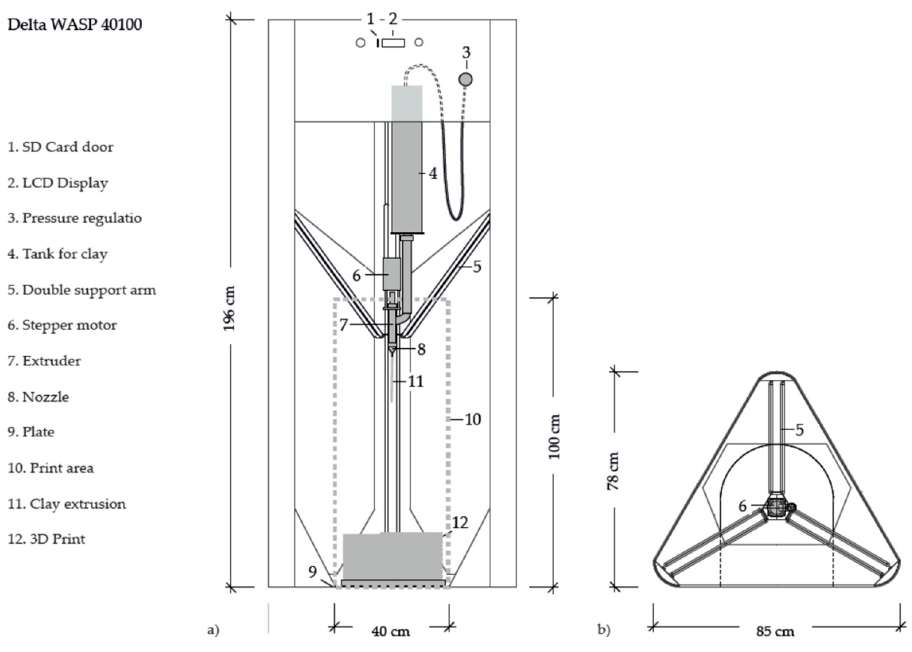
Figure 1. Machine settings: ( a ) front view WASP 40100; ( b ) top view WASP